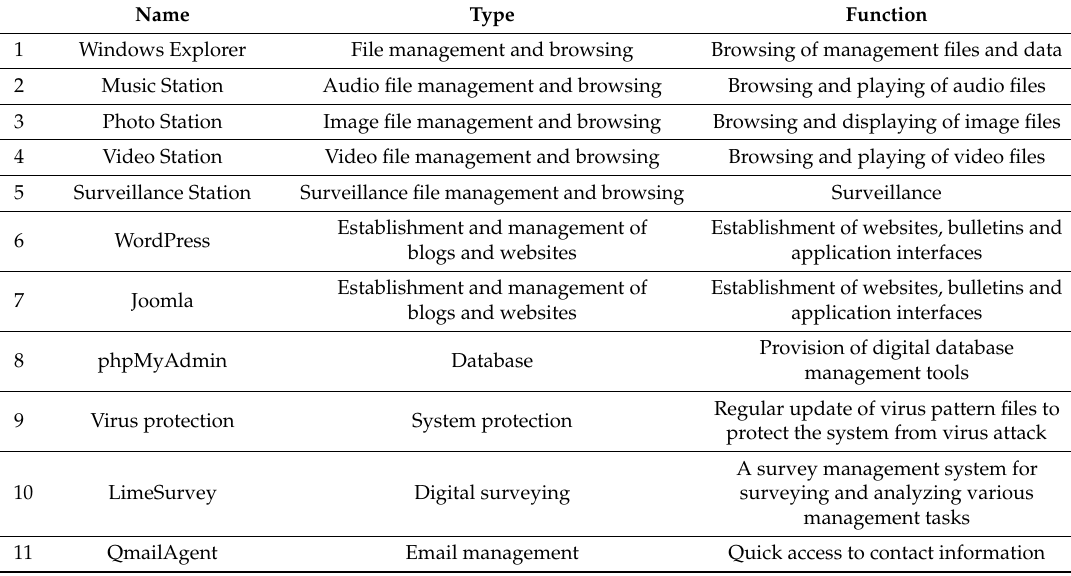
Table 1. Software list for the proposed management